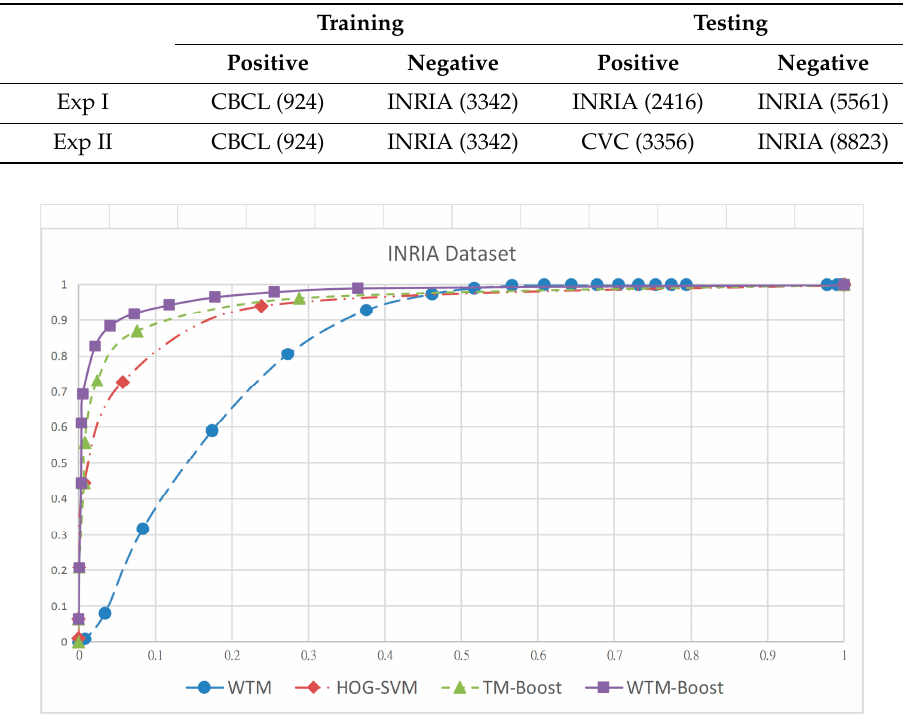
Figure 7. Receiver operating characteristics (ROC) curve for four approaches, WTM, HOG-SVM, TM-Boost, and WTM-Boost on INRIA dataset.